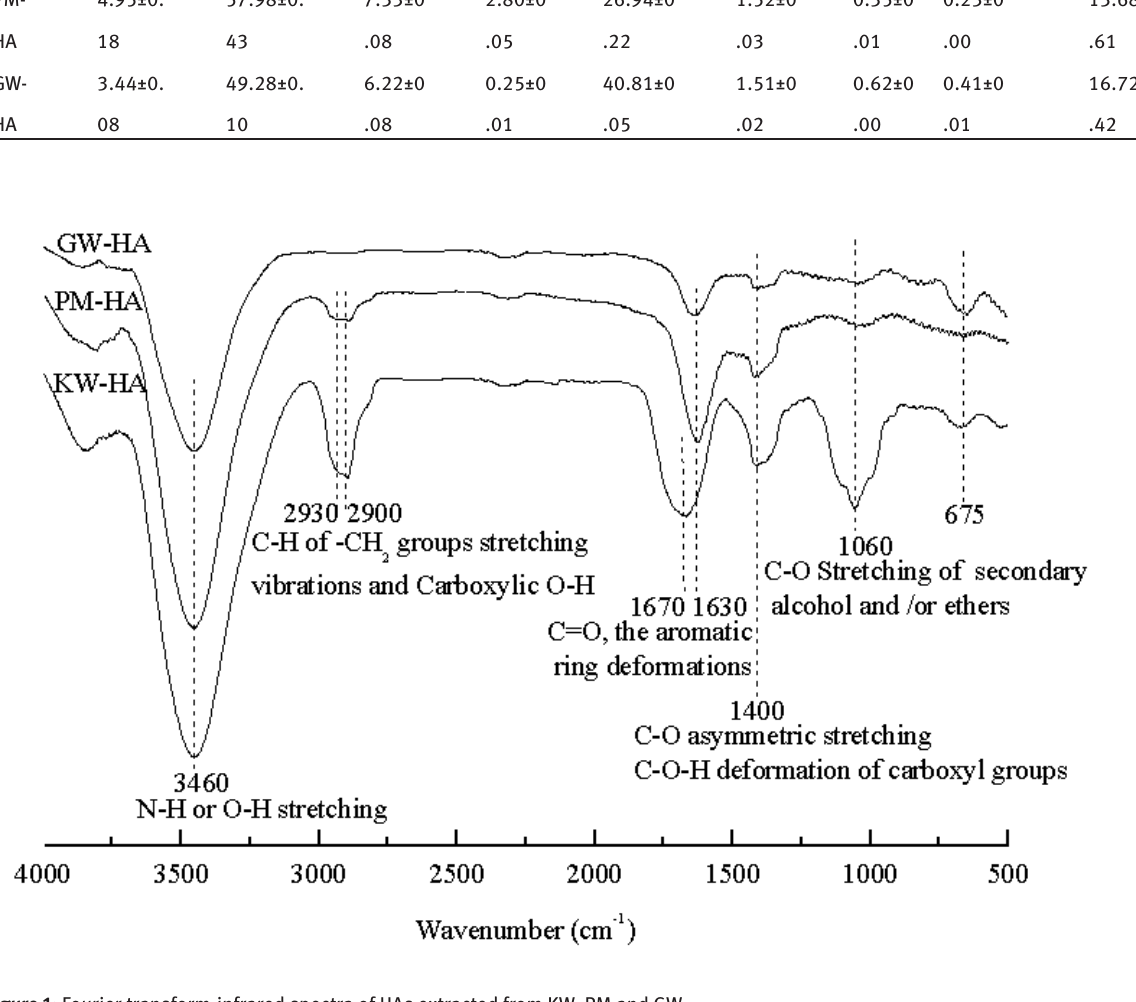
Figure 1: Fourier transform-infrared spectra of HAs extracted from KW, PM and